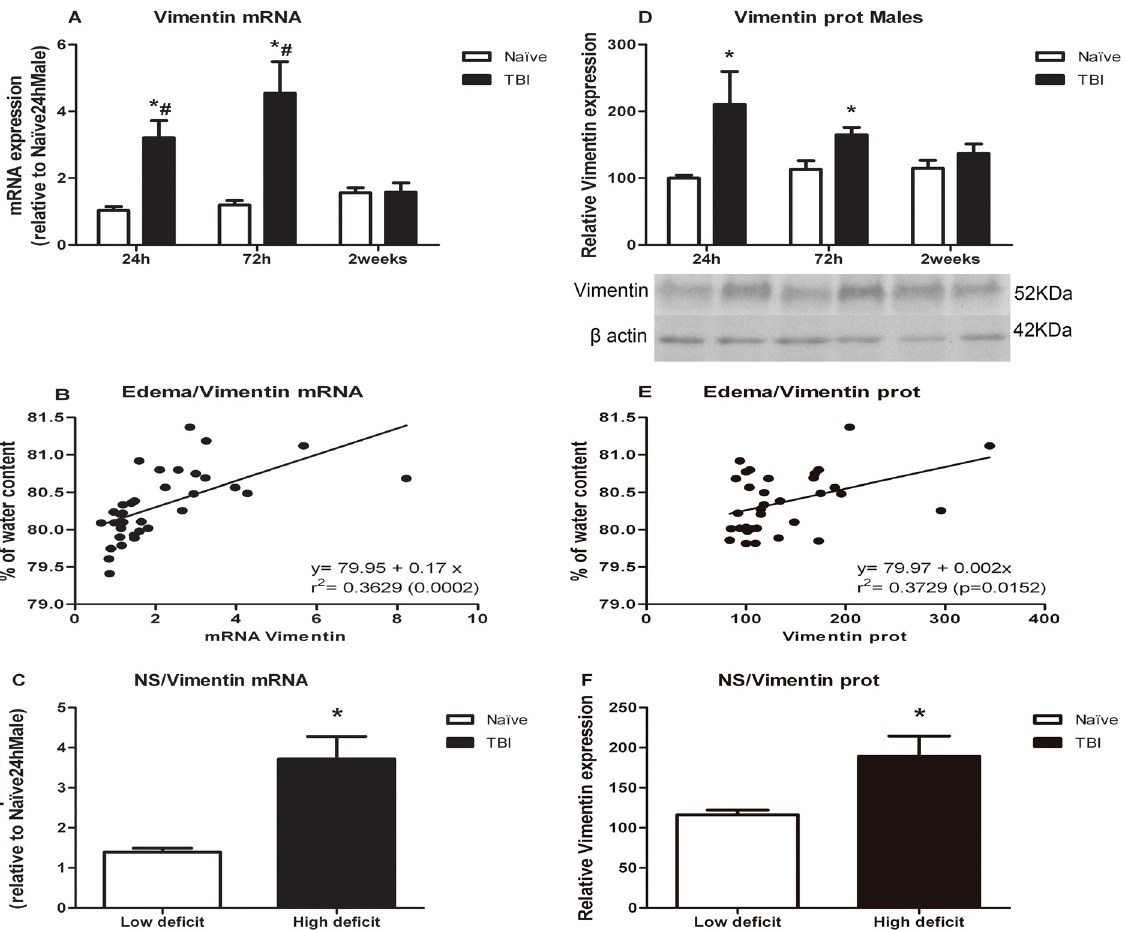
Fig 5. Effects of TBI on vimentin mRNA and protein levels. A) Vimentin mRNA levels. B) Analysis of correlation between brain edema and vimentin mRNA levels. C) Vimentin mRNA levels in animals classified according to neurological score. D) Vimentin protein levels. E) Analysis of correlation between brain edema and vimentin protein levels. F) Vimentin protein levels in animals classified according to neurological score. Data are mean ± SEM. * p < 0.05 versus na ï ve group of same time; # p < 0.05 versus two weeks of same